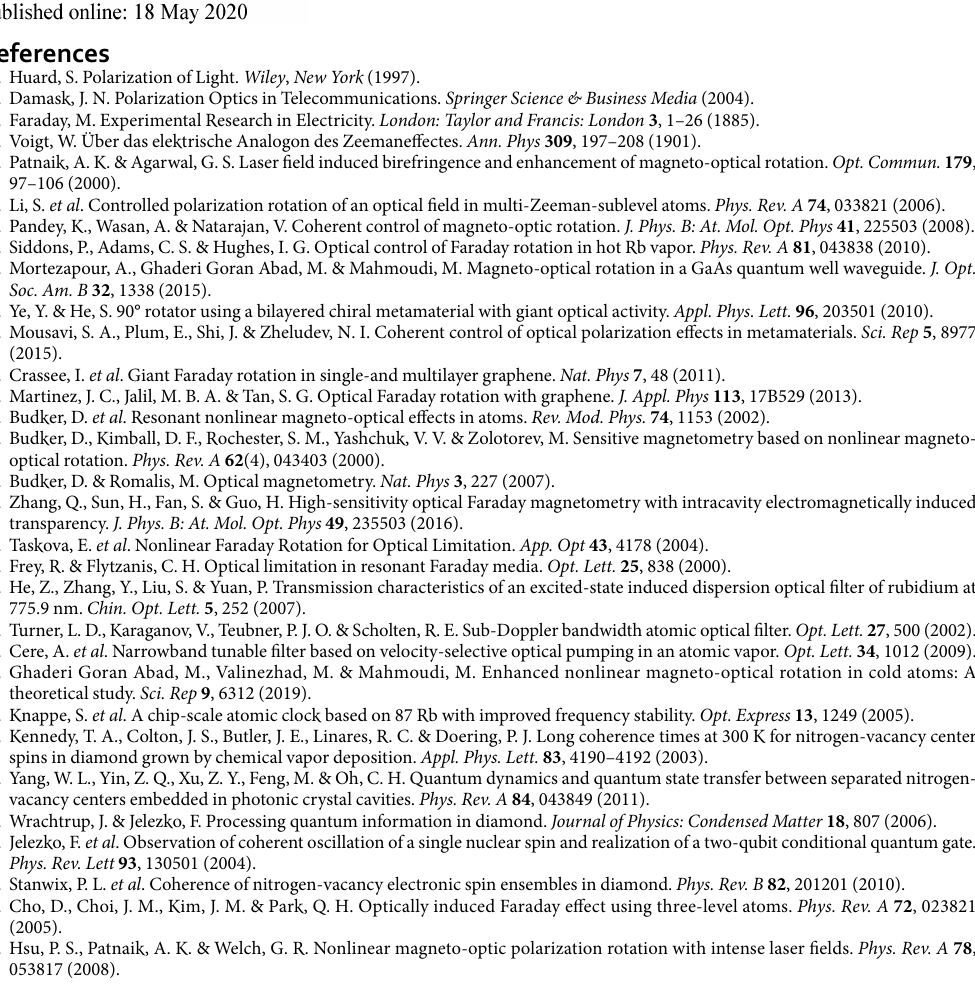
Figure 10. Intensity of the transmission in direction ˆ x (dashed) and T are Ω = . Γ 0